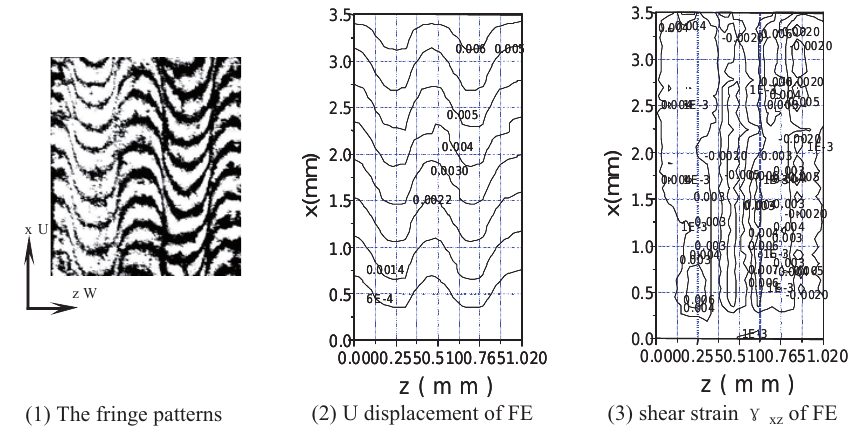
Fig. 5 The interlaminar deformation at the free edge of the [±25] s4 laminated rectangular plate subjected to a uniform axial strain(cid:3)0 (1)The moiré fringe patterns of U field , (2) U displacement and (3) shear strain (cid:164) xz distribution obtained from the FE